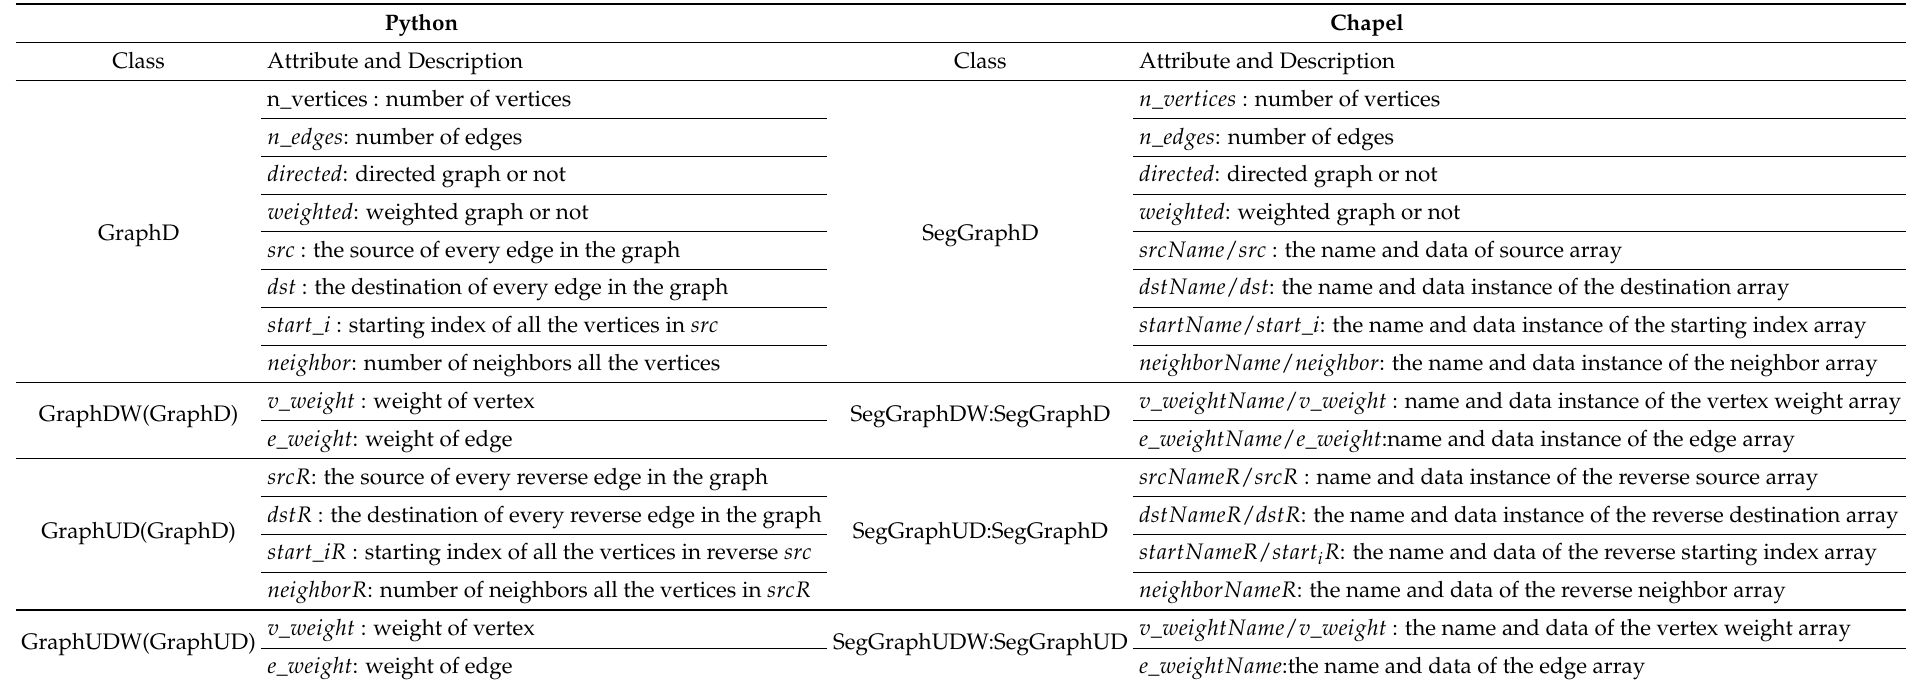
Table 2. Double-Index Sparse Graph Class Definition in Python and